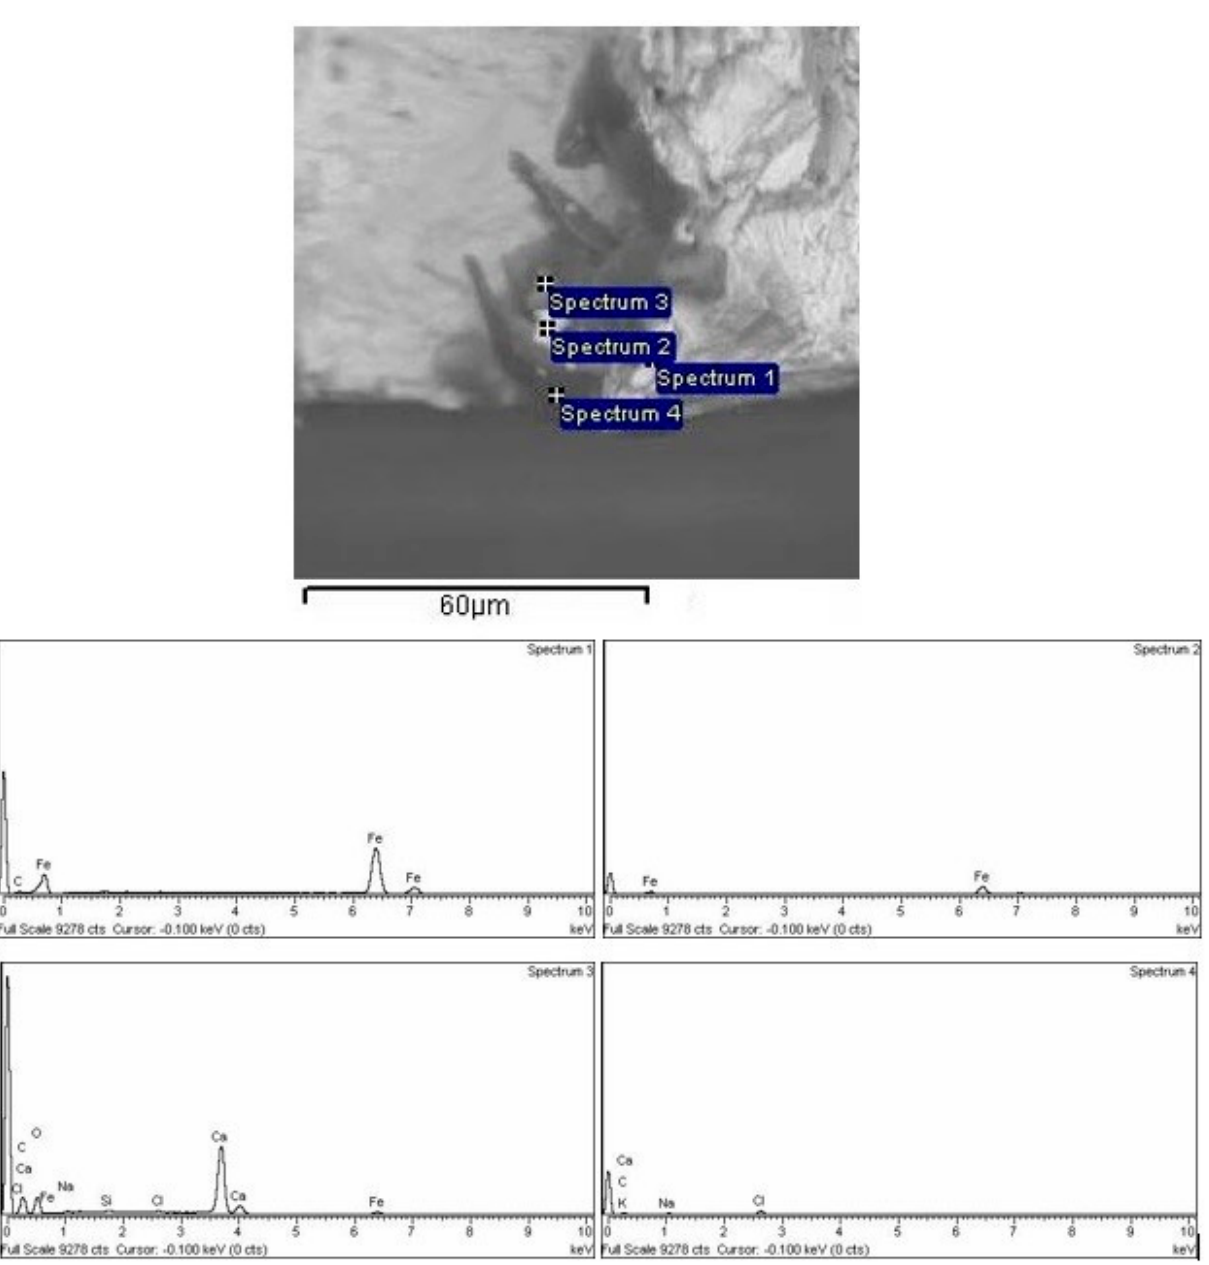
Figure 10. EDS analysis of S235JRC+C: nonmetallic inclusion .